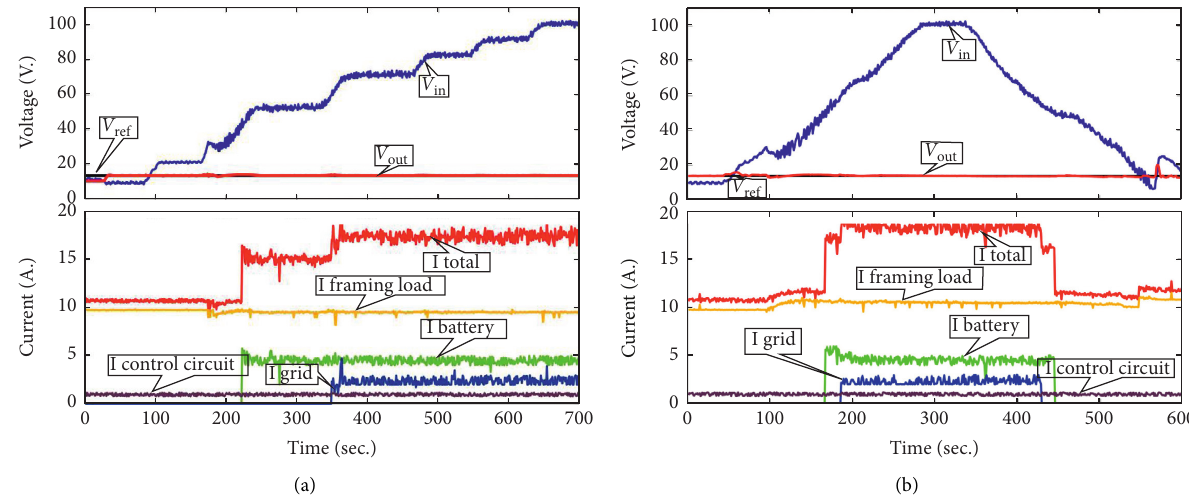
Figure 19: The output voltage response at load. (a) The input supply voltage stair change varying from 5 to 100 V. (b) The input supply voltage varying from 5 to